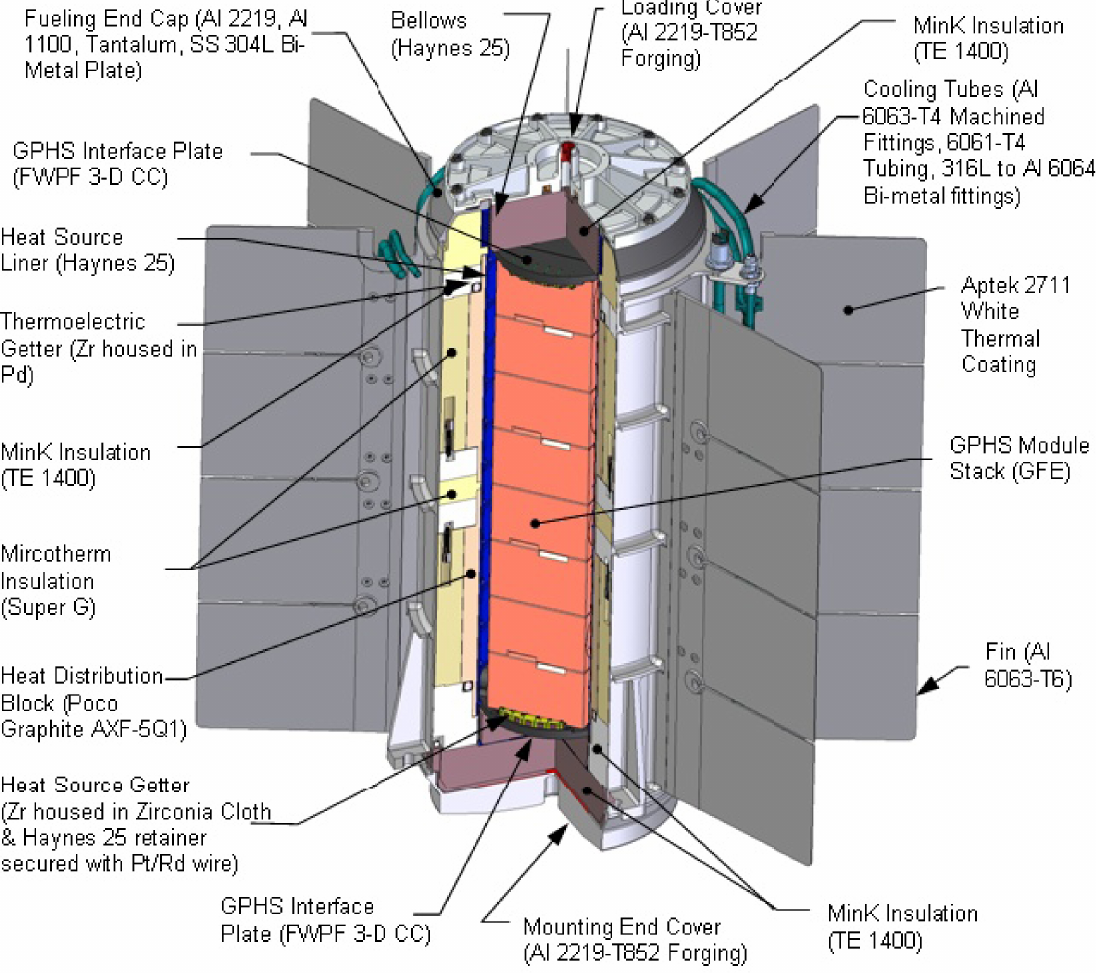
Figure 3. Schematic illustration of a multimission radioisotope thermoelectric generator (MMRTG). Figure extracted from open source (https://commons.wikimedia.org/wiki/File:MMRTG_schematic_ -_english_labels.png; accessed on 18 January